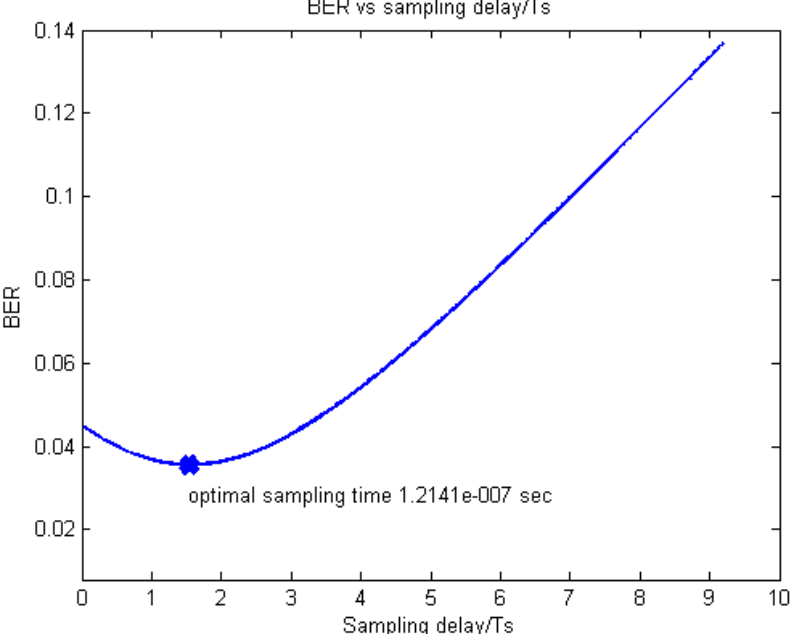
Figure 7. Estimated and simulated BER vs. (optimal) sample time for the exponential LTE FDD downlink.